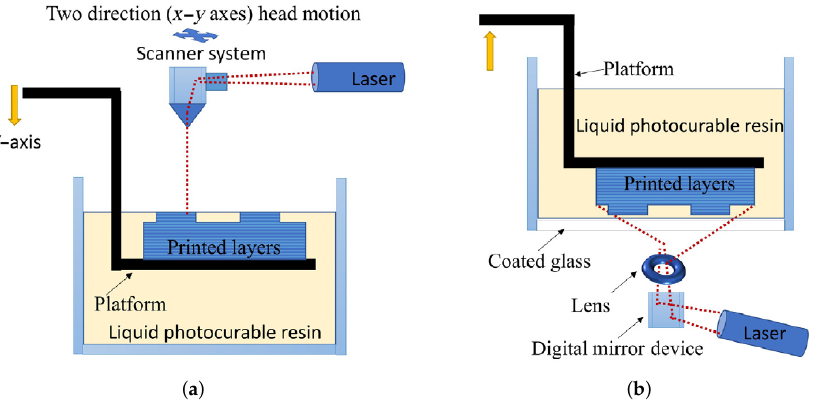
Figure 7. Illustration of the SLA and DLP technologies: ( a ) SLA and ( b ) DLP. (Reprinted from Fiber-Reinforced Nanocomposites: Fundamentals and Applications , 1st Edition, Dikshit, Vishwesh and Goh, Guo Dong and Nagalingam, Arun Prasanth and Goh, Guo Liang and Yeong, Wai Yee, Recent progress in 3D printing of fiber-reinforced composite and nanocomposites, 371–394, Copyright (2020), with permission from Elsevier).